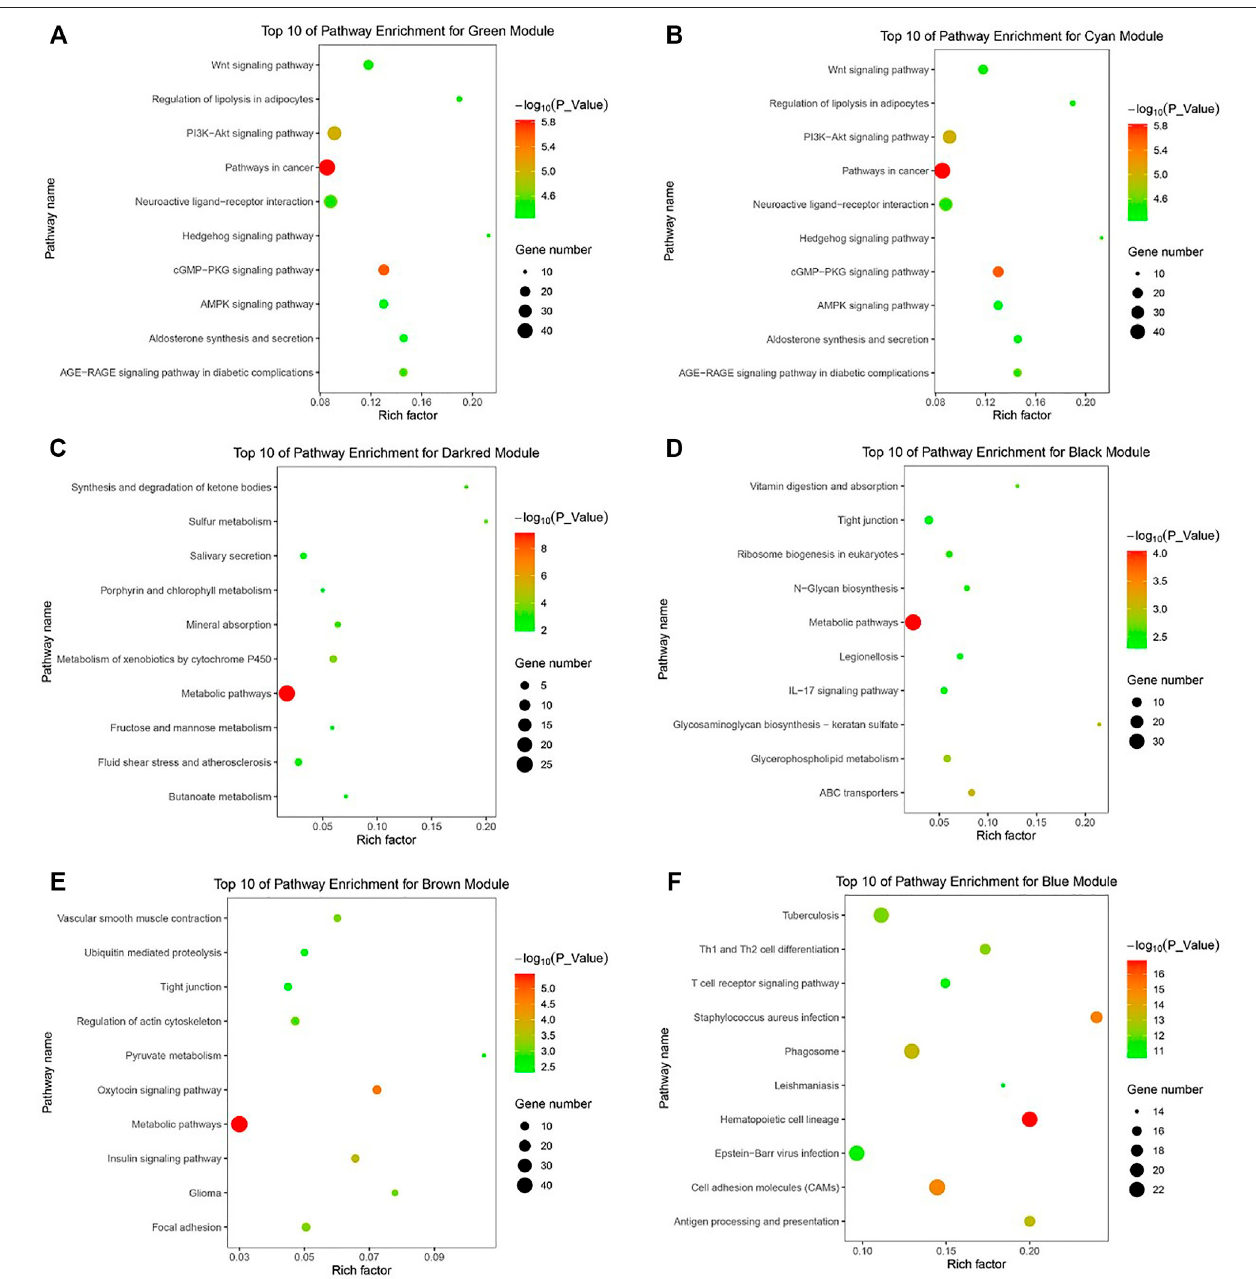
FIGURE 4 | KEGG pathway analysis of related DEGs. (A) The top 10 of pathway enrichment for green module. (B) The top 10 of pathway enrichment for cyan module. (C) The top 10 of pathway enrichment for darkred module. (D) The top 10 of pathway enrichment for black module. (E) The top 10 of pathway enrichment for brown module. (F) The top 10 of pathway enrichment for blue